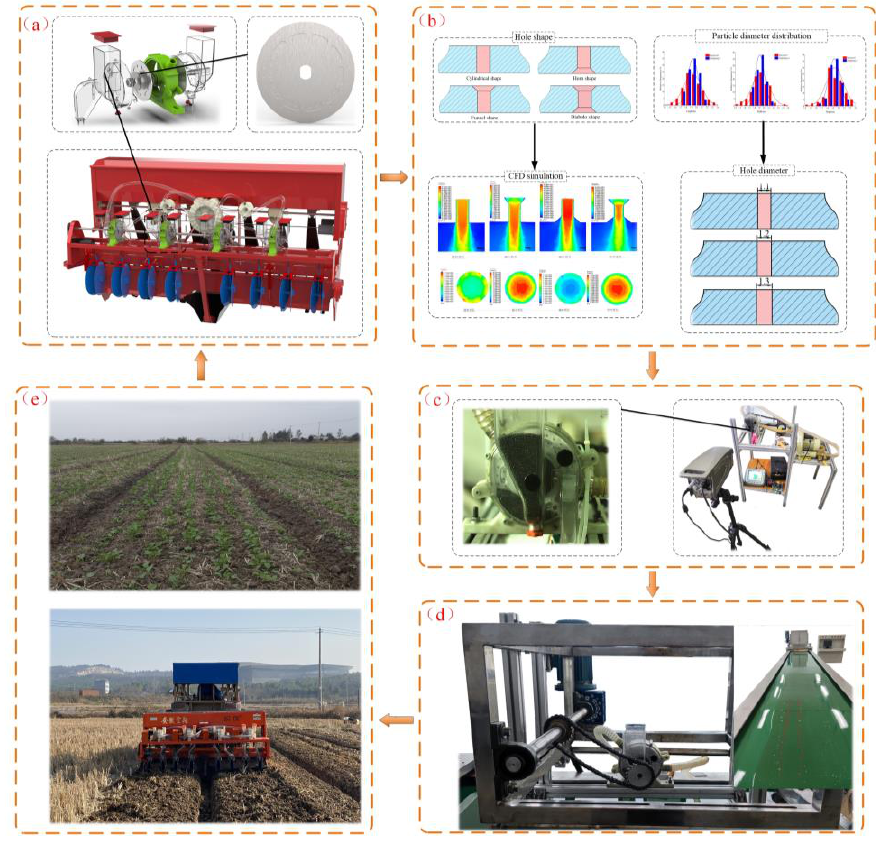
Figure 3. Roadmap for Research and Technology. ( a ) Structure of a seed metering device; ( b ) Simulation and design of type hole structures; ( c ) Test of the performance of seed filling; ( d ) Test of the performance of the seed arrangement; ( e ) Field test and emergence condition.